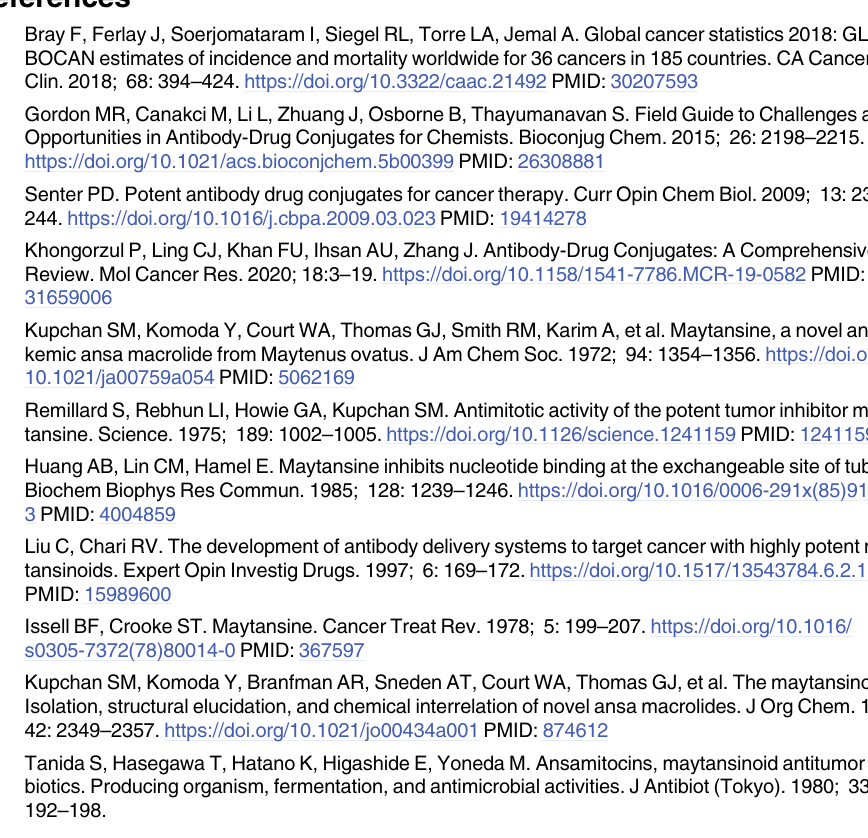
S5 Fig. HPLC spectrum of the fermentation products of ansamitocins. Red arrows showed AP-3, Blue arrows showed AP-2 and